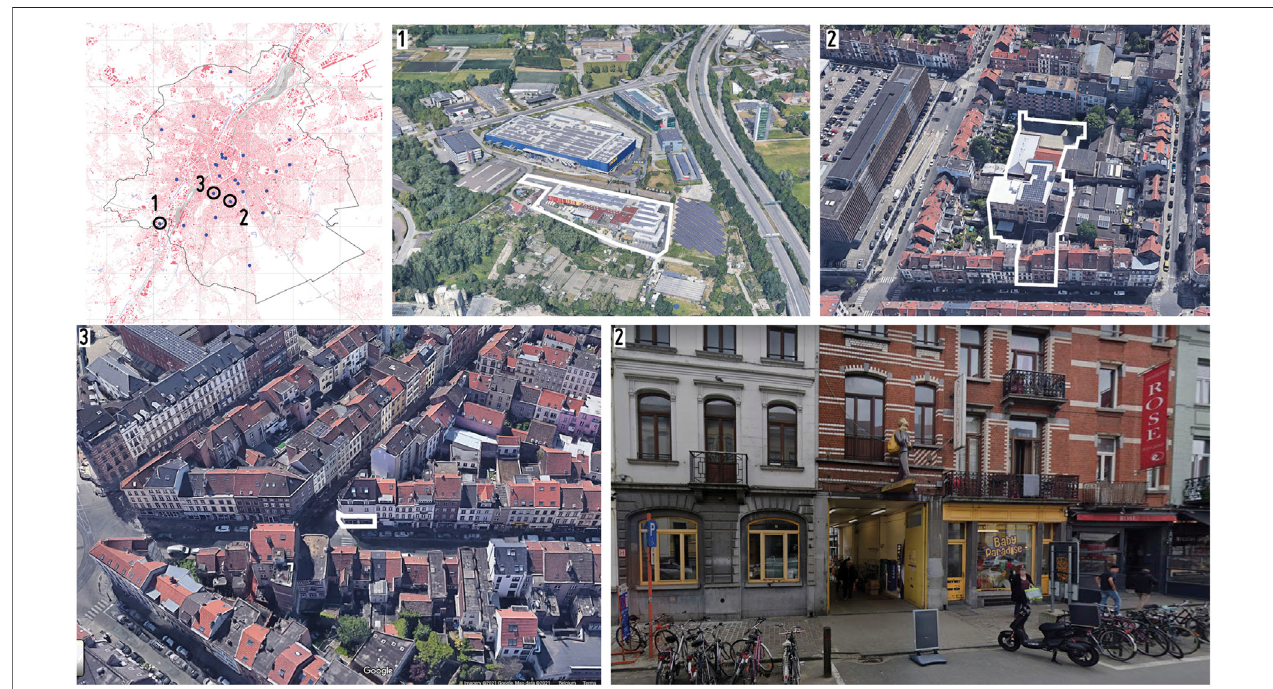
FIGURE 7 | Locations in the BCR, aerial views and street-views from Google Maps of three kinds of infrastructures “ Les Petits Reins-Spullenhulp ” exploits in the BCR (one large warehouse, a large urban shop, and a small one) and a street-view of the warehouse and shop in the municipality of Ixelles (Rue Américaine 101). September 2021. By the authors.